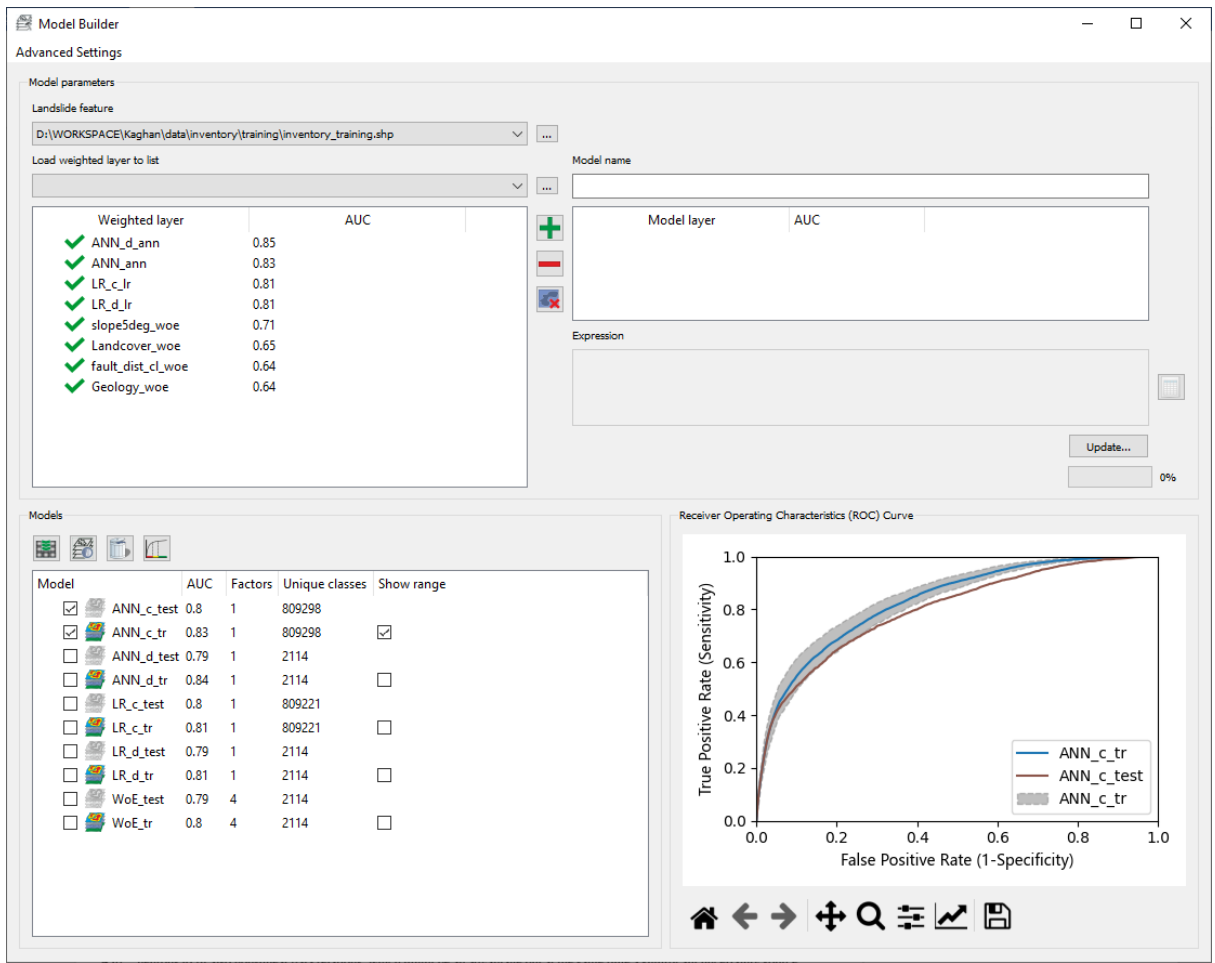
Figure 9. Evaluation and comparison of the models in